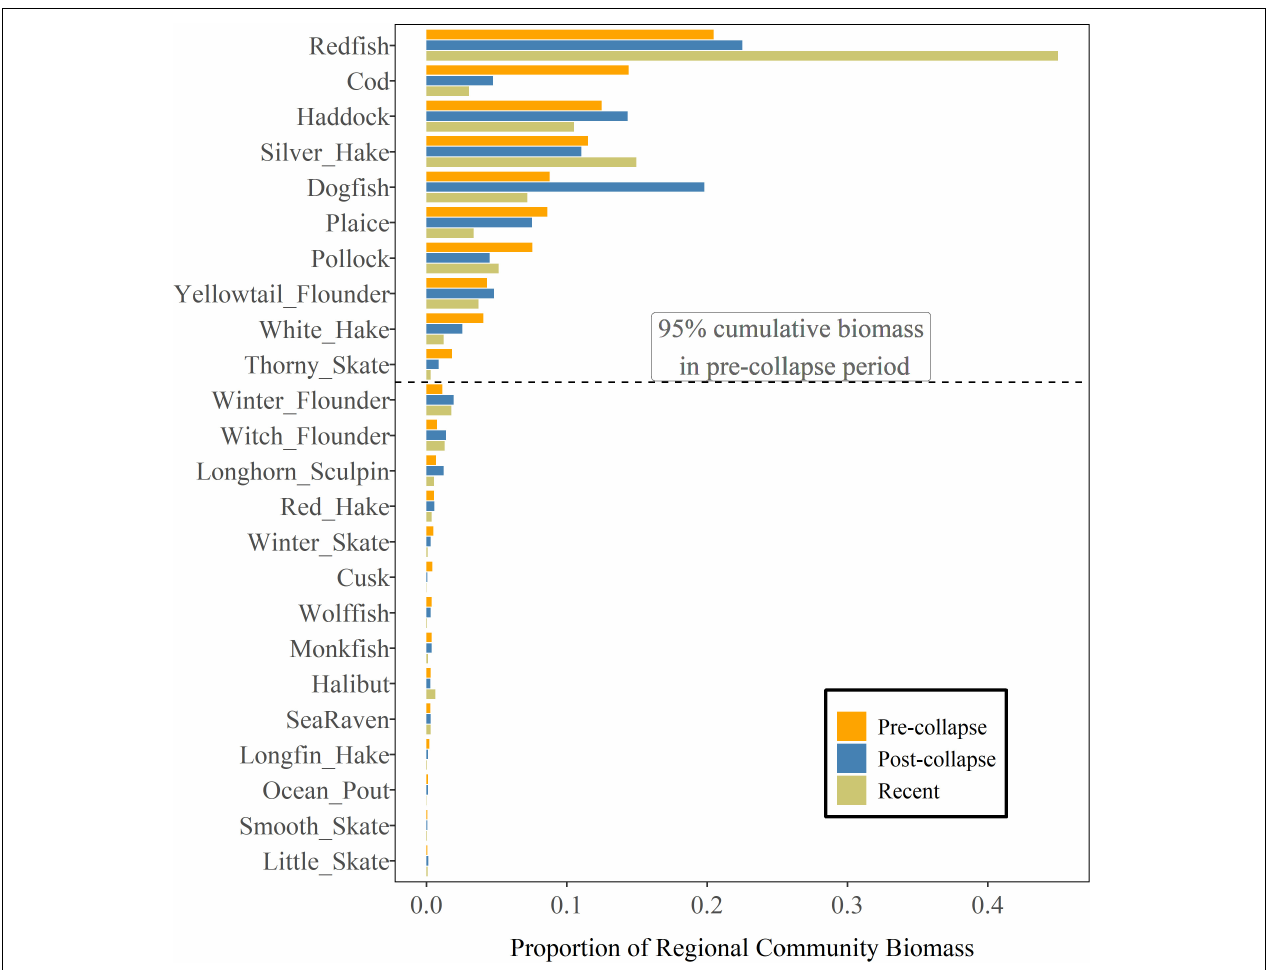
FIGURE 3 | Regional groundfish community structure as indexed by the proportion of regional community biomass on the Scotian Shelf during pre-collapse (1979–1992), post-collapse (1993–2005) and most recent periods (2006–2017). Species are ordered by their proportion of total biomass during the pre-collapse